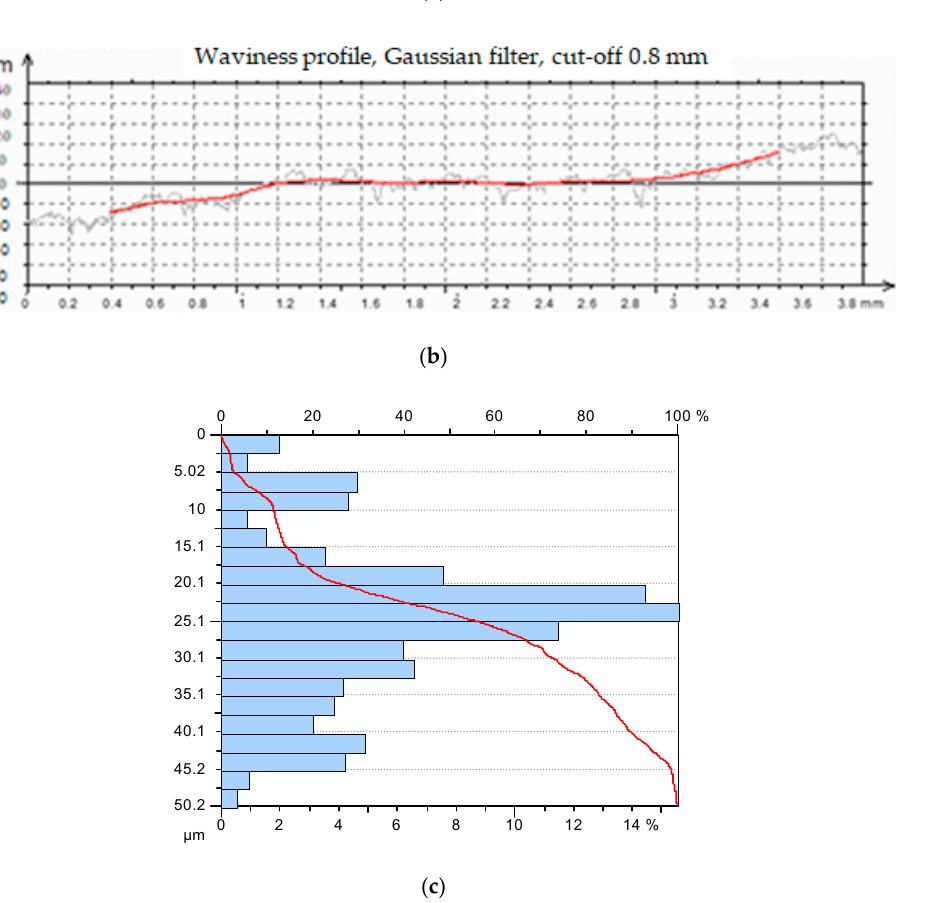
Figure 6. Profile, roughness, and bearing curves for the 3/1 roller: ( a ) Profilogram, ( b ) Profilogram and corrugation, and ( c ) The bearing (Abbott–Firestone) curve.